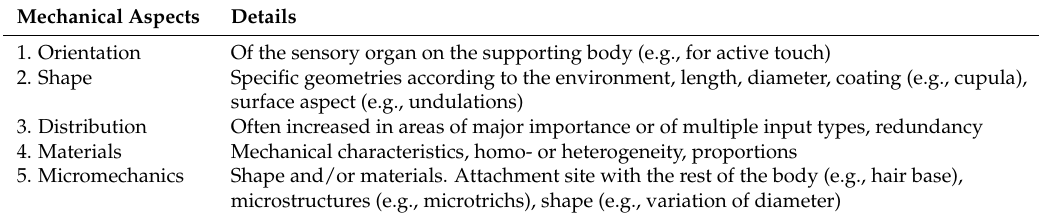
Table 2. Mechanical aspects of specialized mechanical sensory organs, which are transversal to different morphology types and